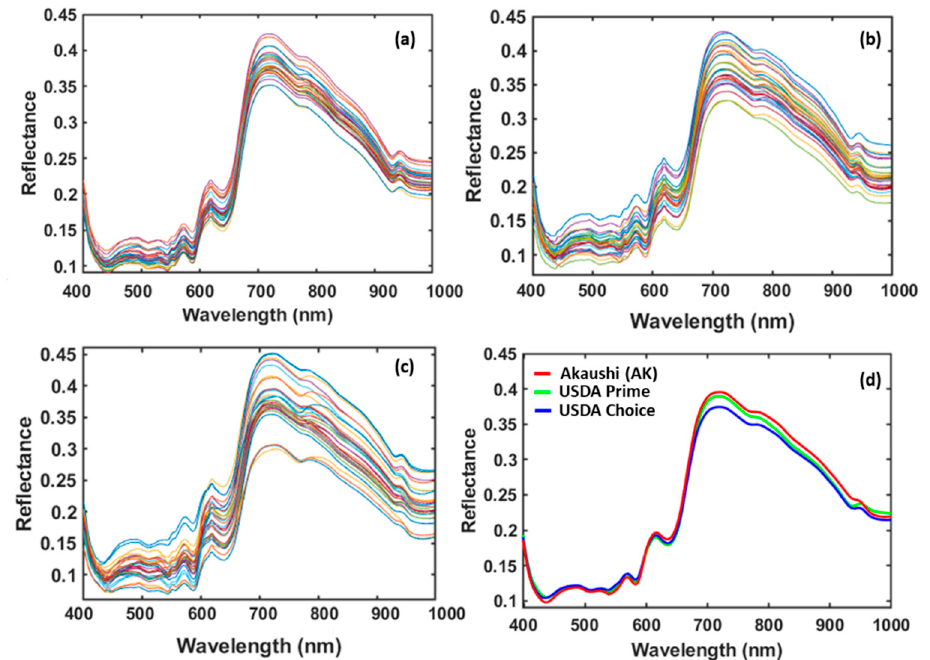
Figure 3. Raw spectra of ( a ) Akaushi prime, ( b ) USDA prime, and ( c ) USDA choice. ( d ) Mean spectra of all 3 classes. Table 1. PLS-DA model classification results applying different pre-processing methods.